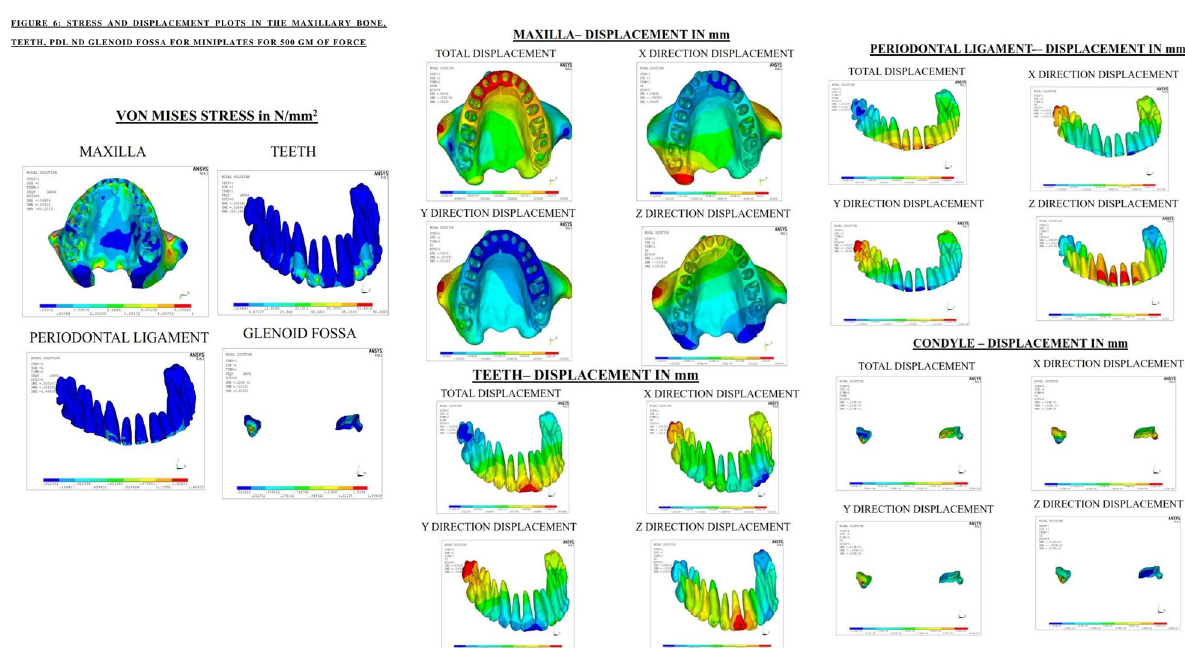
Fig. 6 Stress and displacement plots in maxillary bone, teeth, PDL and glenoid fossa with miniplates for 500 g of